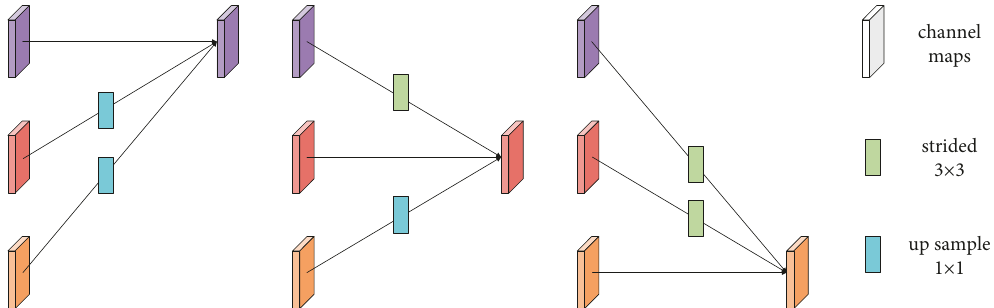
Figure 3: Multiscale text feature fusion.